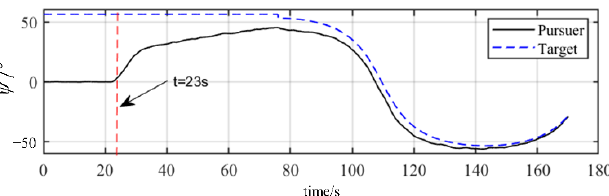
Figure 5. Heading angles of pursuer and evader.